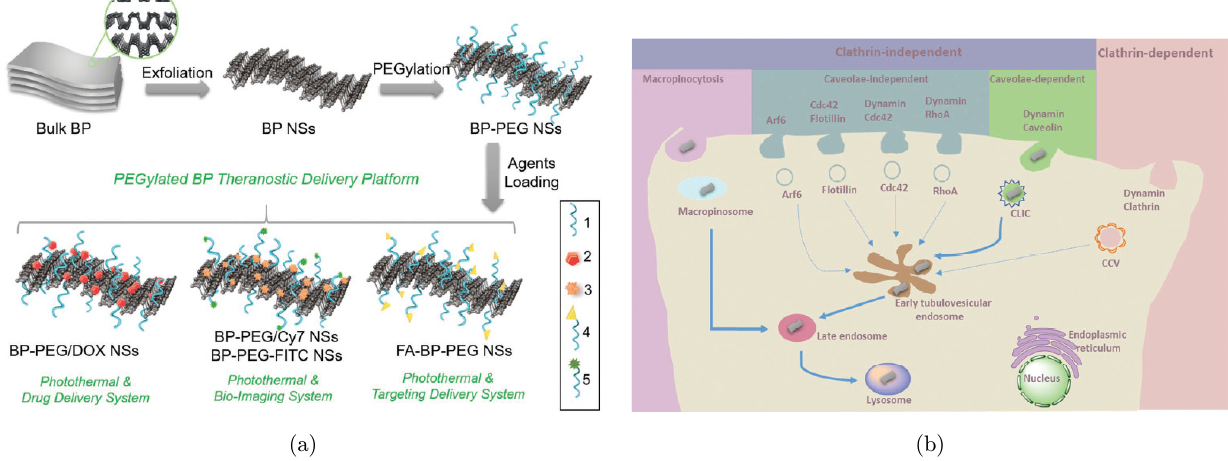
Fig. 5. (a) Schematic representation of the FLBP nanoparticle. 1: PEG-NH2 (surface modi¯cation), 2: DOX (therapeutic agents), 3: Cy7-NH2 (NIR imaging agents), 4: FA-PEG-NH2 (targeting agents), 5: FITC-PEG-NH2 (°uorescent imaging agents). (b) The endocytosis pathway of the FLBP